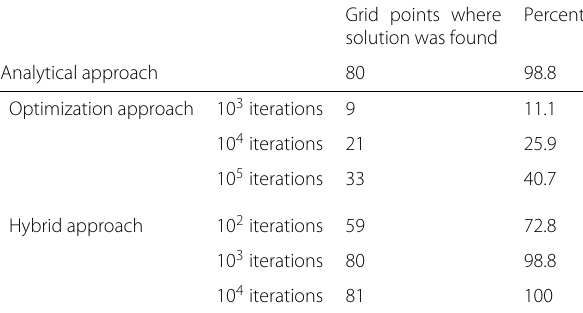
Grid points where Percent solution was found